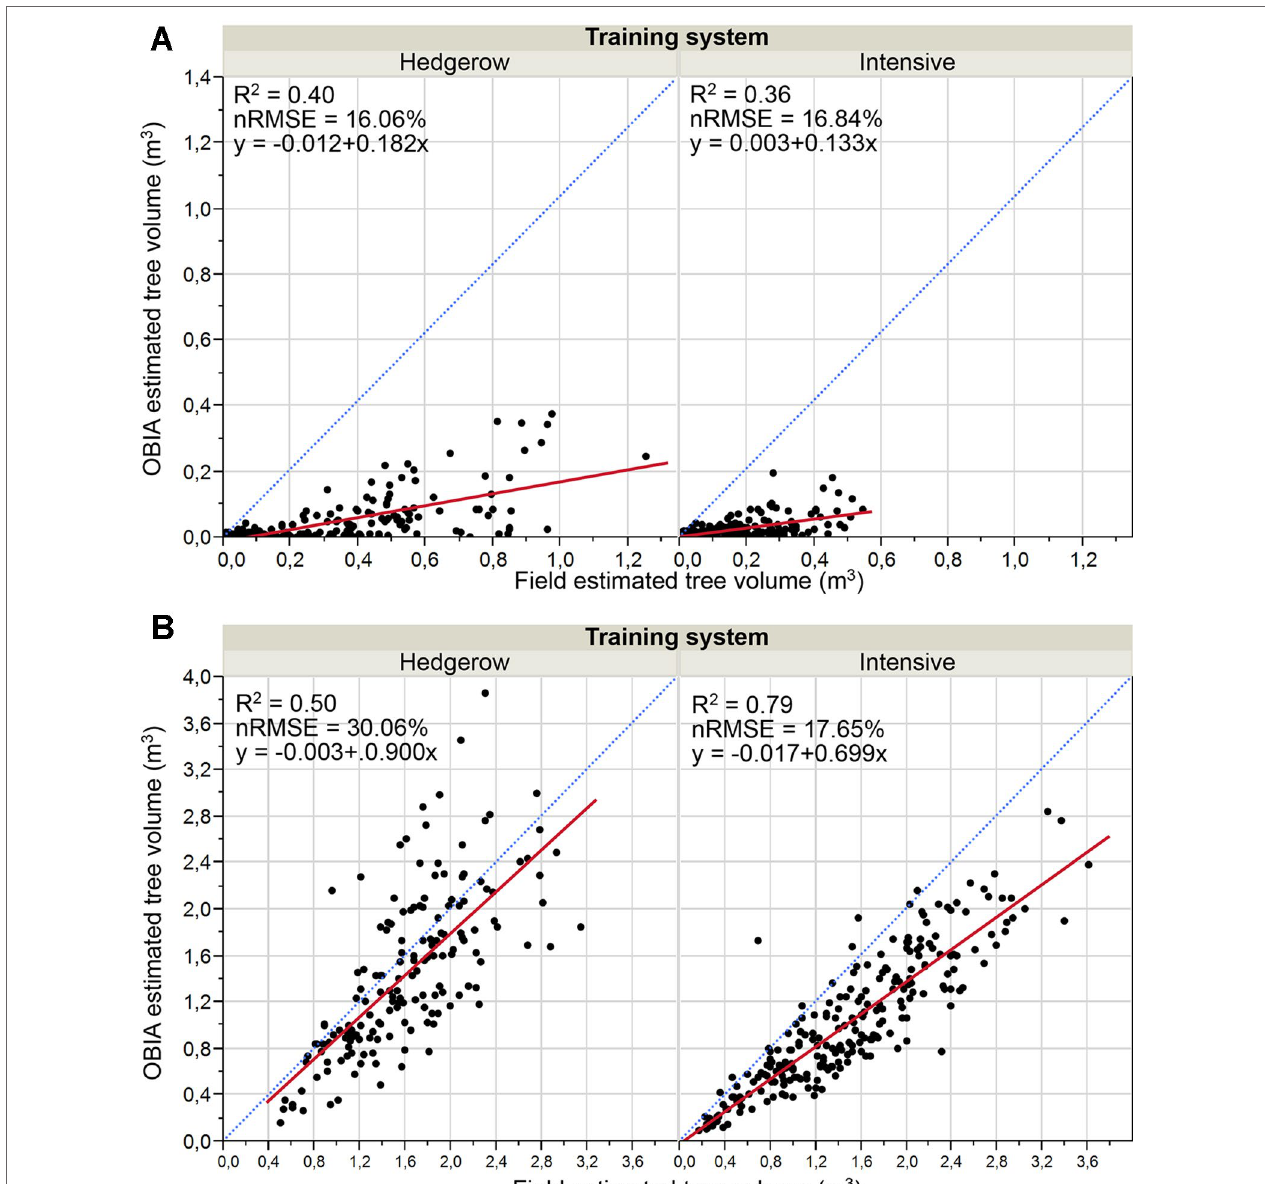
FIgUrE 9 | Graphic comparisons of Point cloud-OBIA estimated and field estimated crown volume by pattern system in: (A) January 2017, 15 months after olive plantation; (B) January 2018, 27 months after olive plantation. The normalized root mean square error (nRMSE) and coefficient of determination (R 2 ) derived from the regression fit are included for every scenario (p 0.0001). nRMSE was computed as the percentage of the average of measured values of tree variables. The red solid line is the fitted linear function and the blue dashed line represents the 1:1 line.